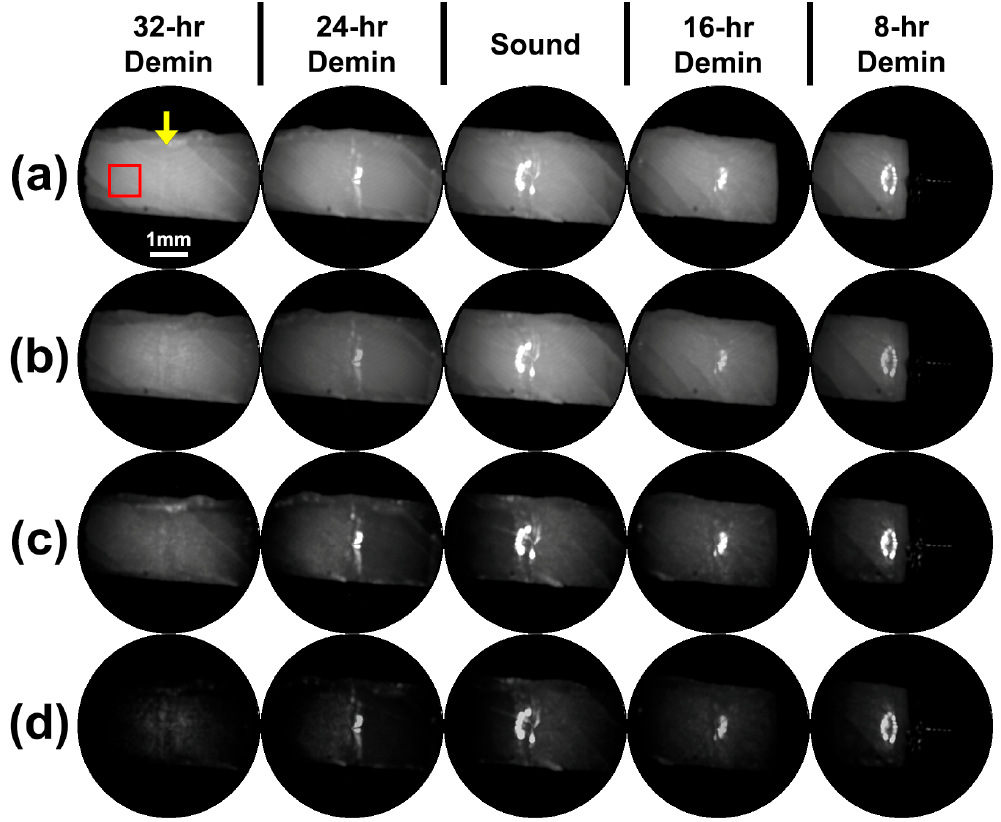
Figure 5. Raw NIR SFE image of the sample shown in Figure 3. Four sets of images were taken: ( a ) dry sample imaged with SFE operating at 1310-nm, ( b ) wet sample imaged with SFE operating at 1310-nm, ( c ) dry sample imaged with SFE operating at 1460-nm, and ( d ) wet sample imaged with SFE operating at 1460-nm. The left window in the SFE field of view is the corresponding window labeled on the top. The red square box outlines the region of interest (ROI) where the mean value was recorded for statistical analysis. The same position of ROI was used for all images of each sample. A yellow arrow indicates the trough line dividing two windows shown in an image frame.